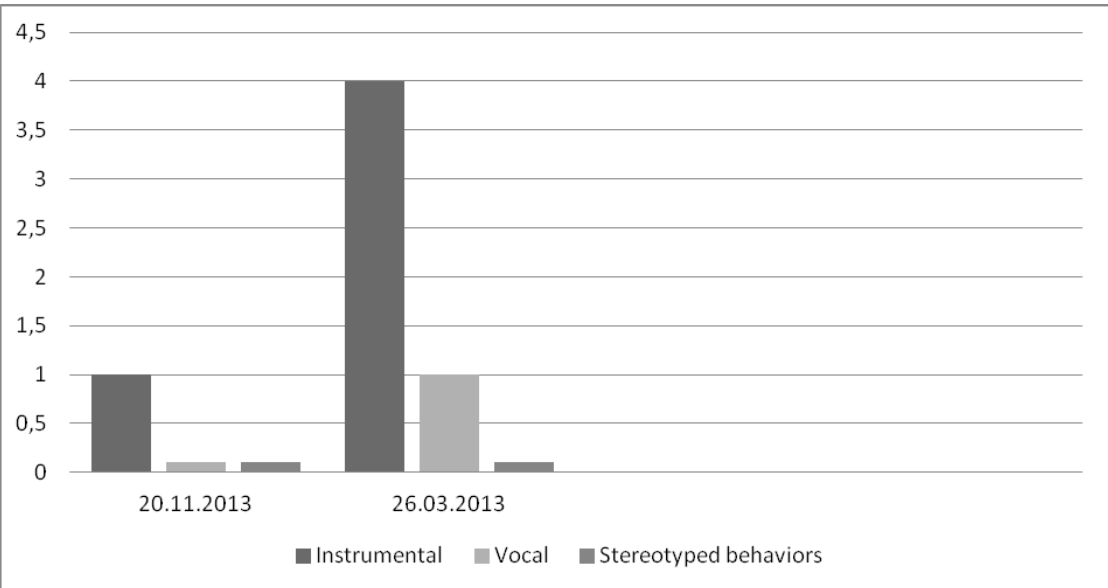
Fig. 1. Participation in musical interaction (a (cid:222) ve-year-old boy)